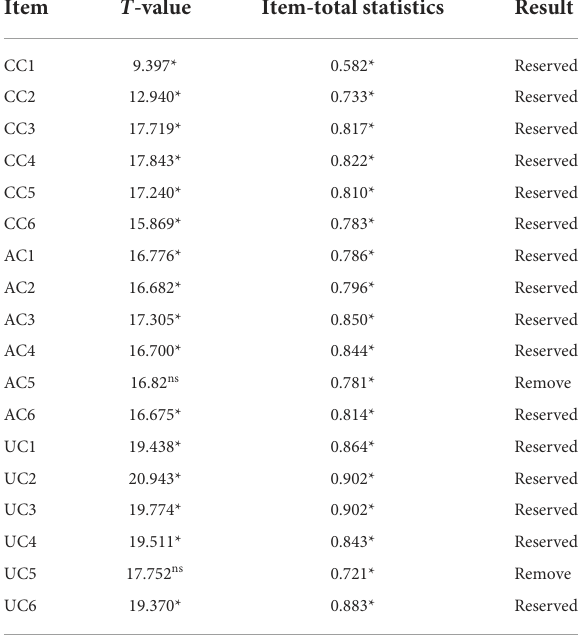
TABLE 6 Items analysis ( N =